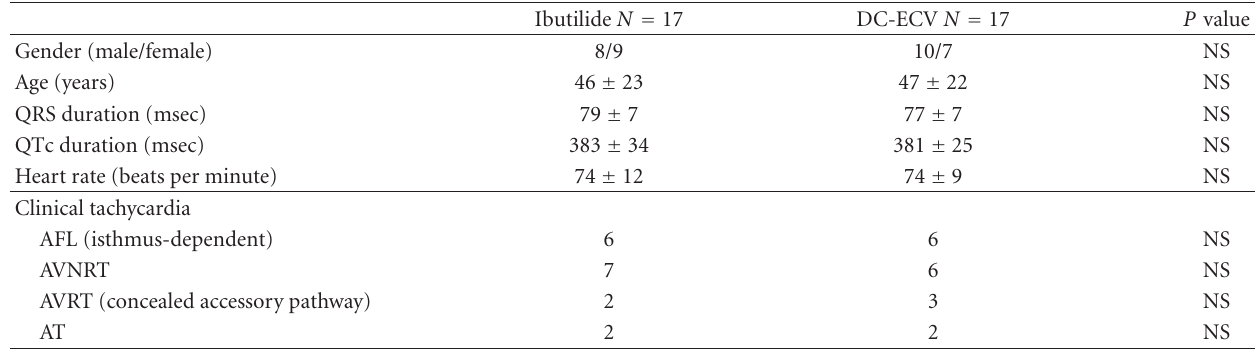
Table 1: Population